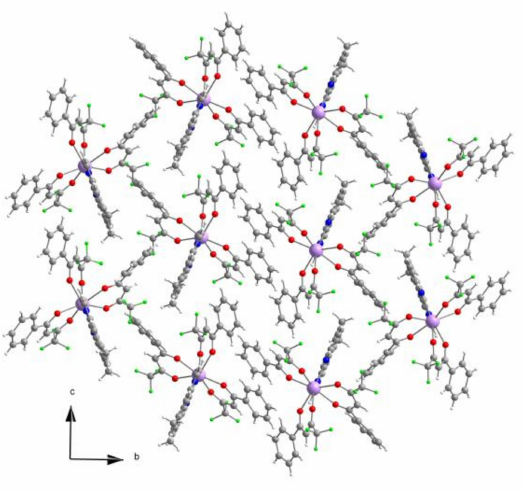
Figure 4. Packing diagram of the structure of [Eu 0.0135 Gd 0.9865 (pta) 3